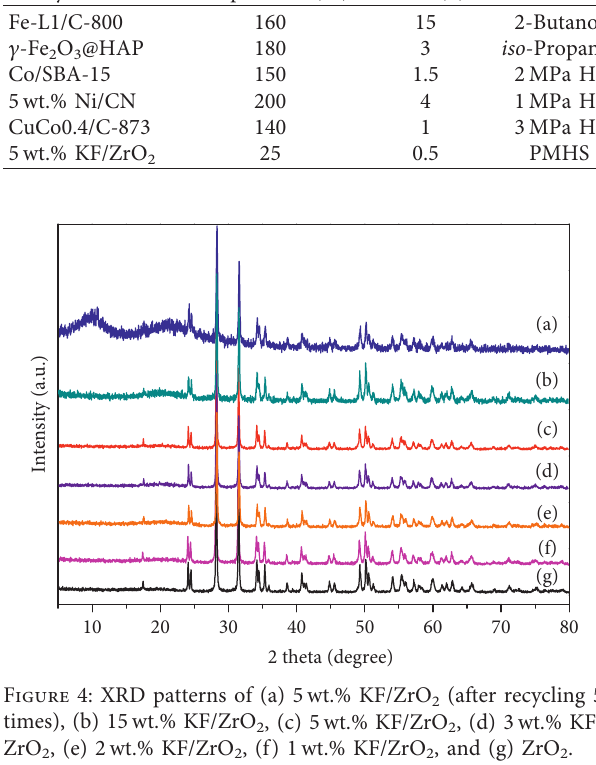
2 , (b) ZrO 2 , and (c)